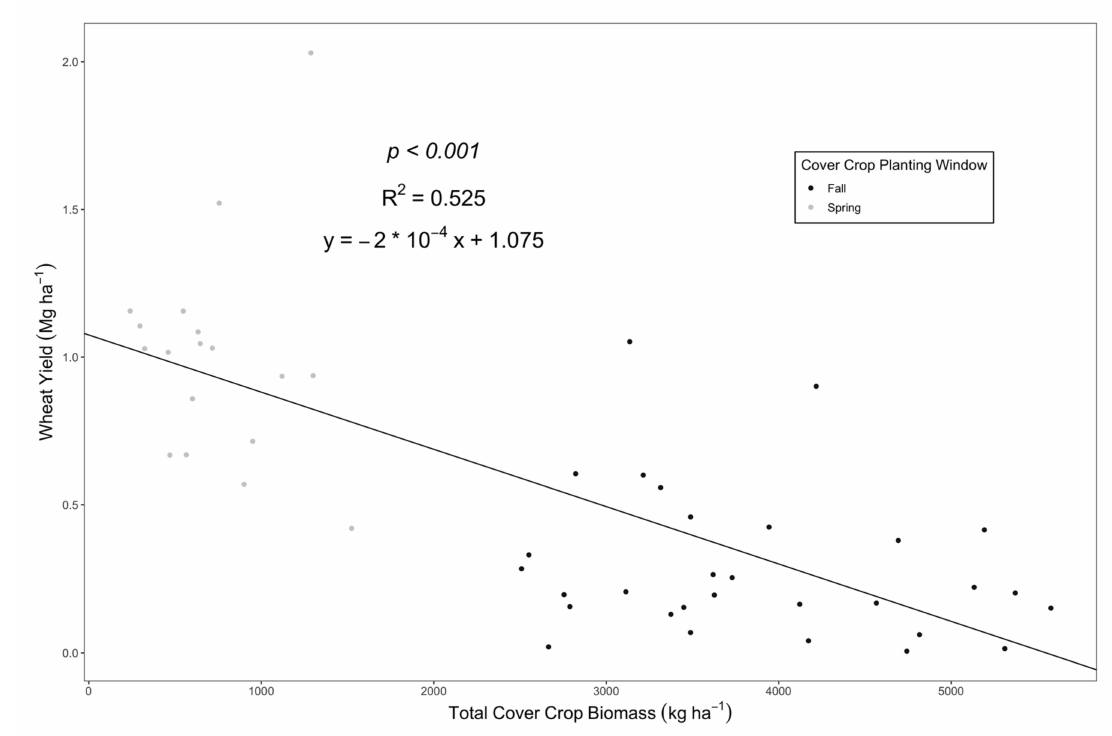
Figure 1. Correlation (R 2 = 0.525; p < 0.001) between fall- and spring-planted cover crop biomass (2017) and subsequent winter wheat yields (2018) in a field experiment (T2) located at the Southwestern Colorado Research Center in Yellow Jacket,